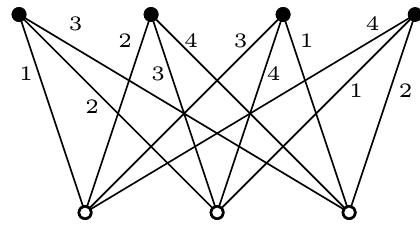
Figure 3: Edge-coloring the complete bipartite graph K 4 , 3